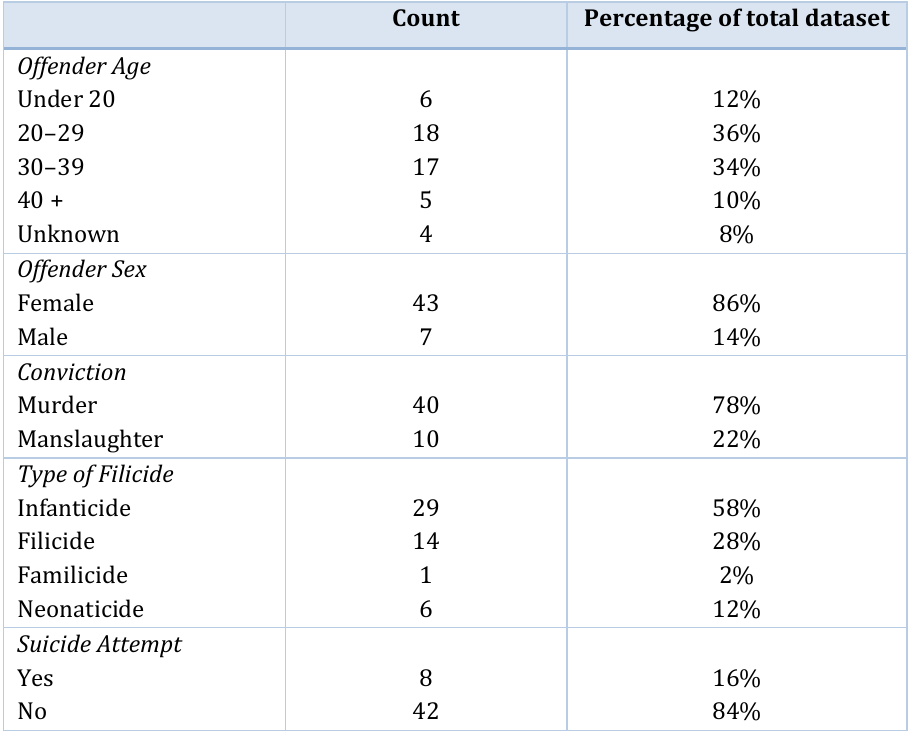
Table 1: Filicide Offender and Offence Characteristics, Victoria, 1860 – 1920